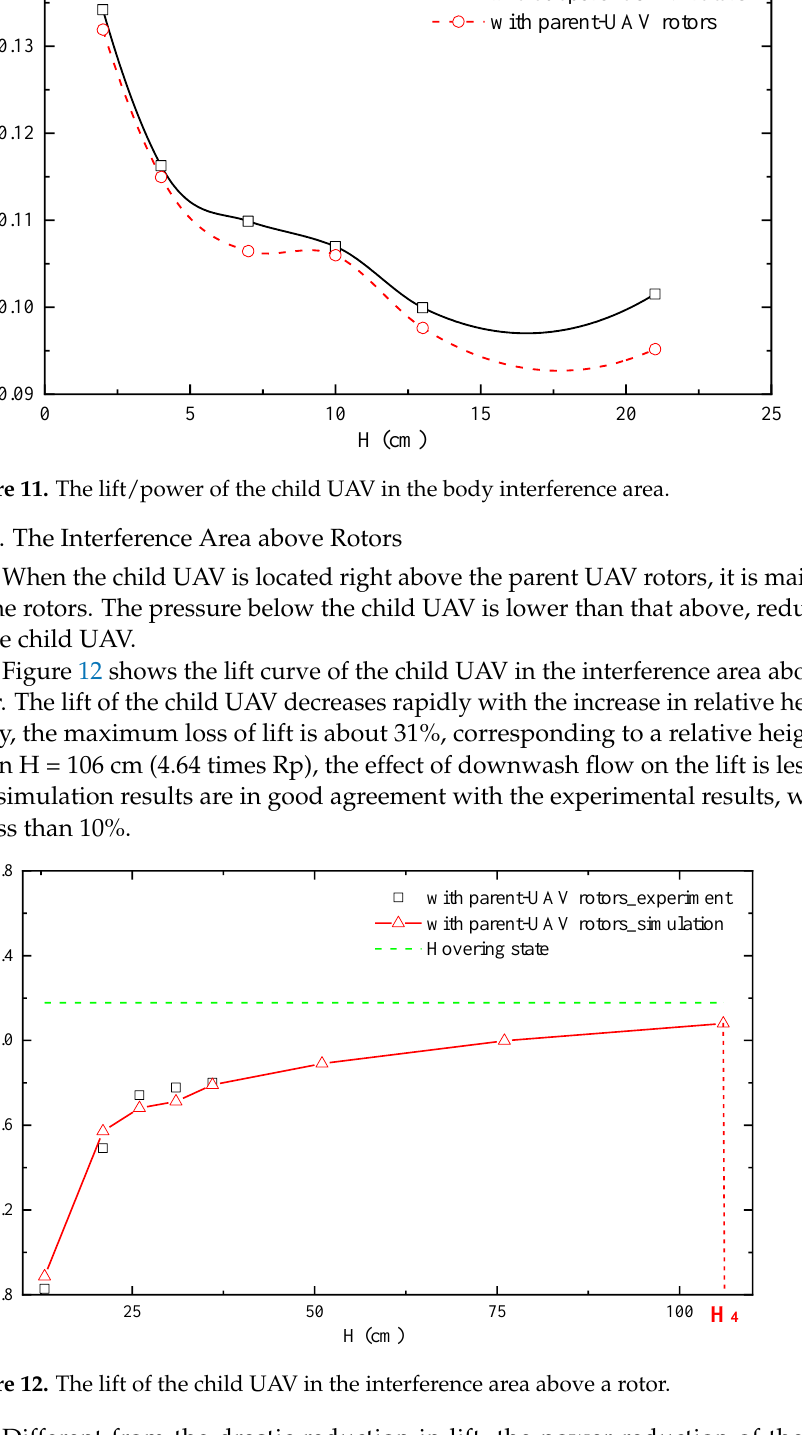
Figure 12. The lift of the child UAV in the interference area above a rotor. Different from the drastic reduction in lift, the power reduction of the child UAV at different relative heights is less than 5%. The lift/power of the child UAV in